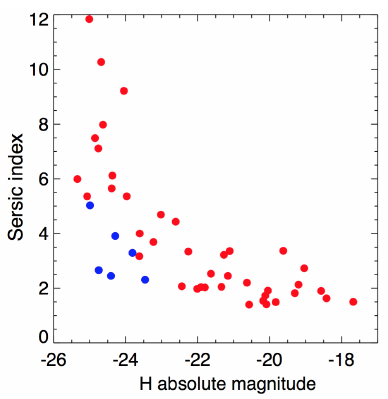
Figure 2. Sérsic index, n , as function of H absolute magnitude derived from 2MASS photometry. Blue circles show Virgo ellipticals from [14], while red symbols are our Las Cumbres